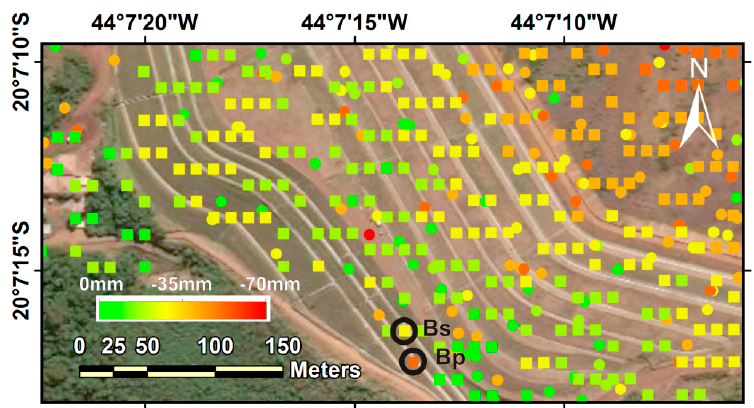
Figure 15. SBAS and PSI results combined and the locations of Bs and Bp points (black circles), which are the SBAS and PSI points with the highest accumulated deformation values on the dam bottom; SBAS MPs are represented by square symbols, and PSI MPs are represented by round symbols.